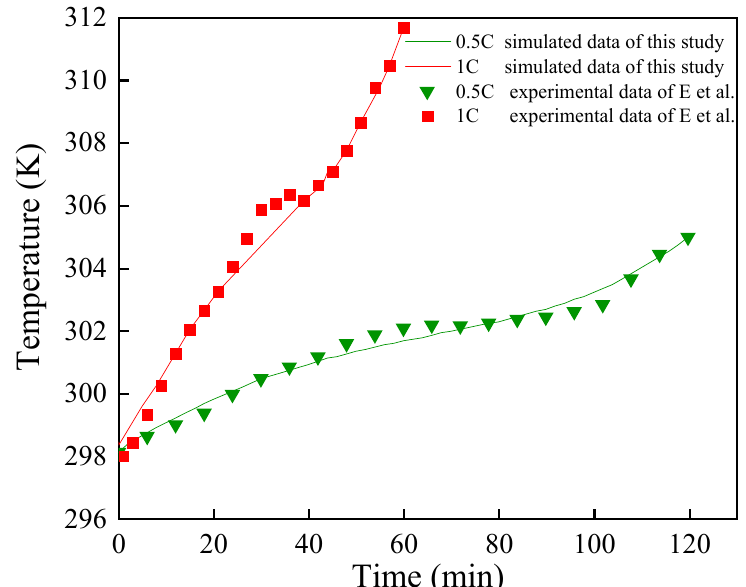
Figure 5. Heat generation model validation for a single battery. Reprinted with permission from ref. [41]. Copyright 2018, Copyright Applied Thermal Engineering.